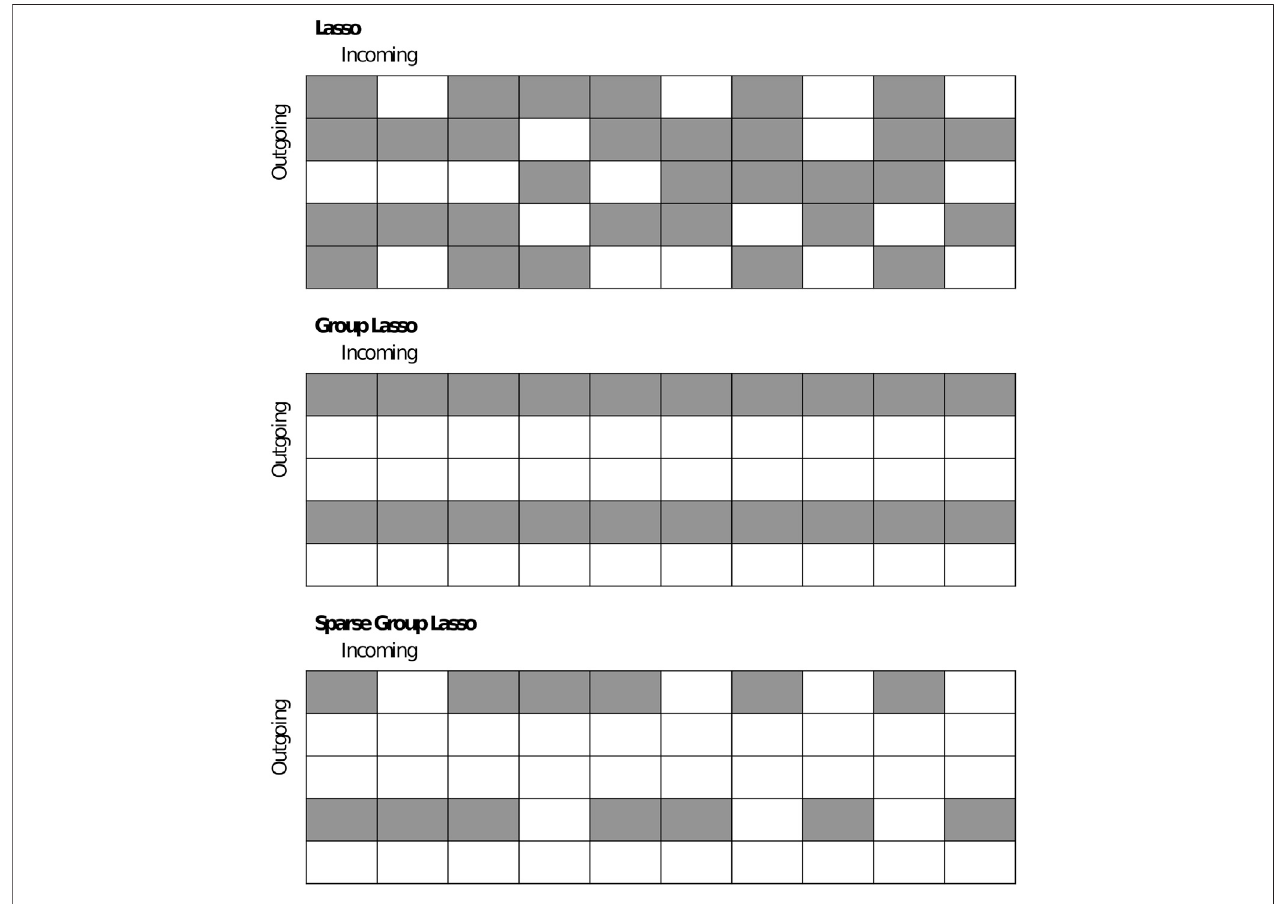
FIGURE1| Comparisonbetweenlasso,grouplasso,andsparsegrouplassoappliedtoaweightmatrix.Entriesinwhitearezero ’ edoutorremoved;entriesingray remain.